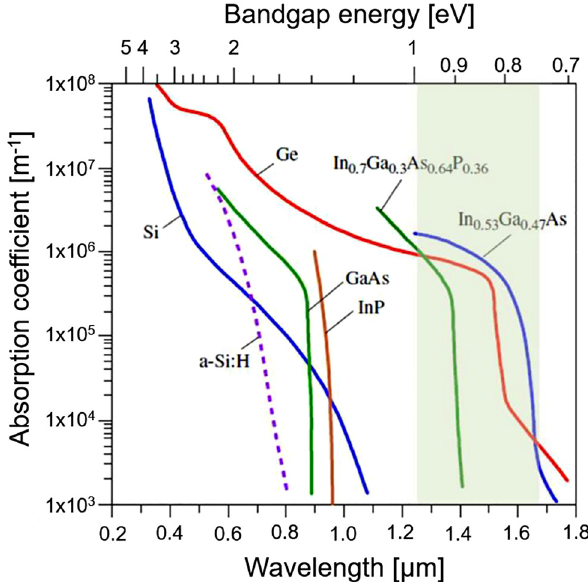
Figure 1: Absorption coefficient as a function of the wavelength and bandgap energy for several semiconductors typically harnessed in optical photodetectors. Figure adapted from a study by Virot